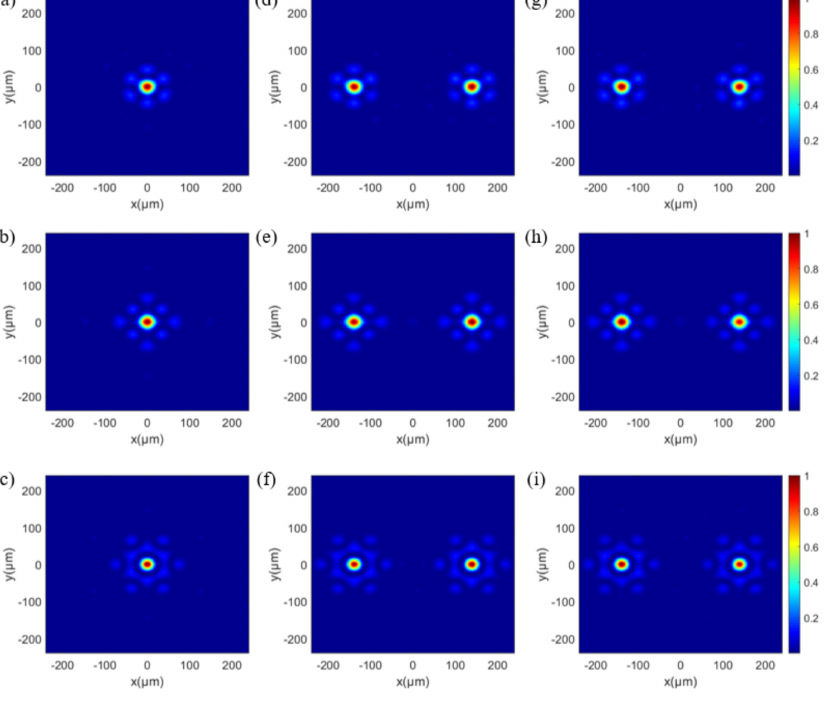
Figure 11. ( a – c ) The PSFs of PI − SAMs with structures of Golay3, Cross and Annulus, respectively. ( d – f ) The PSFs of OLP − SAMs with structures of Golay3, Cross and Annulus, respectively. ( g – i ) The PSFs of OCP − SAMs with structures of Golay3, Cross and Annulus,